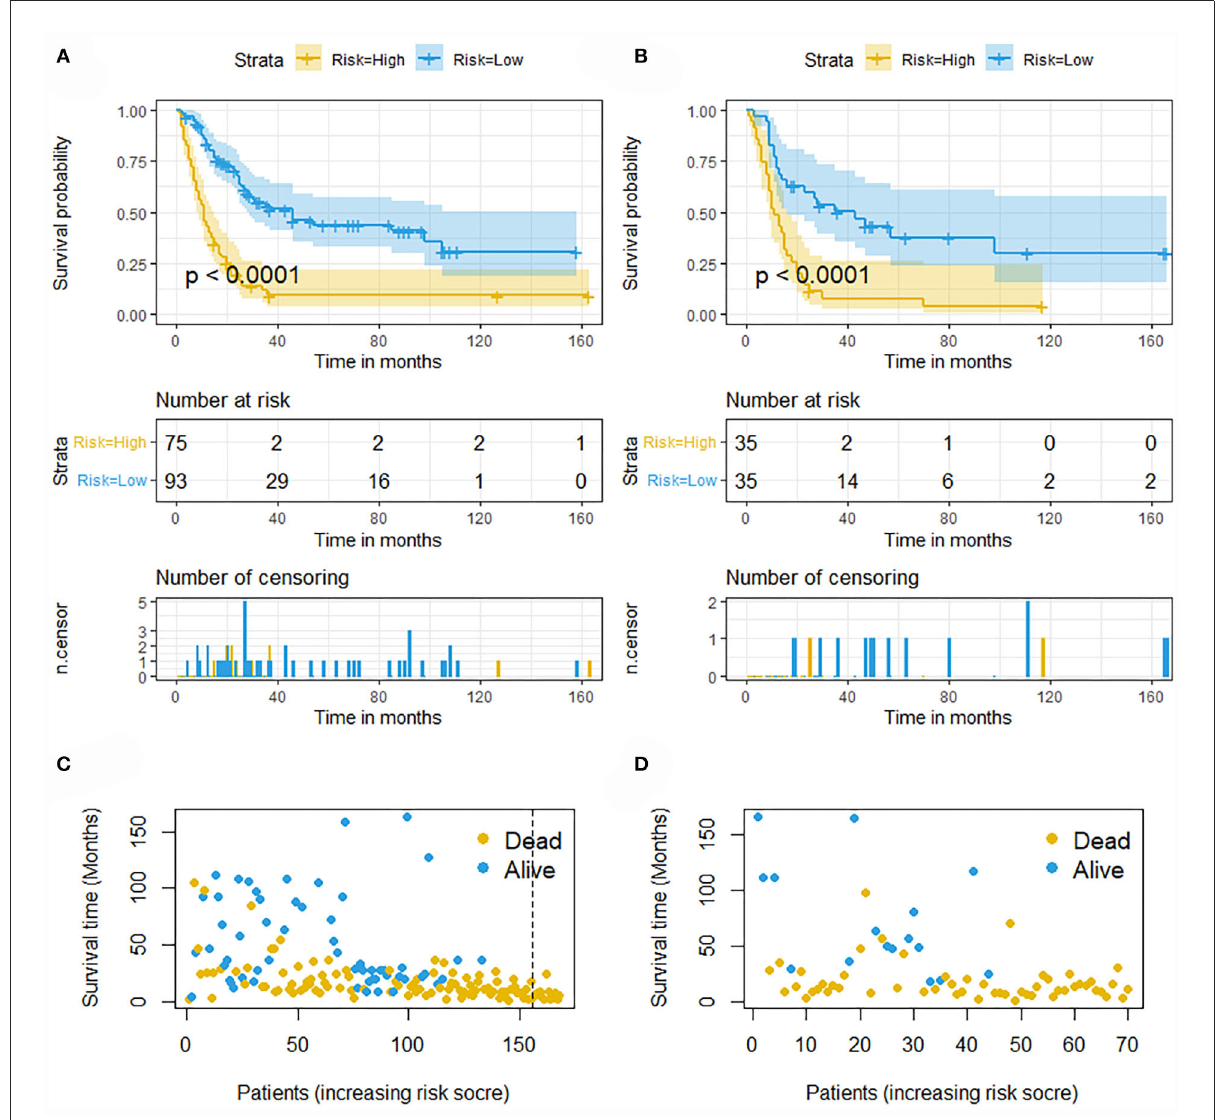
FIGURE12 Kaplan–Meier survival curves of two mortality risk subgroups in the training set (A) and validation set (B) . Kaplan–Meier survival status analysis for patients with POSNs with DM in the training set (C) and validation set (D)